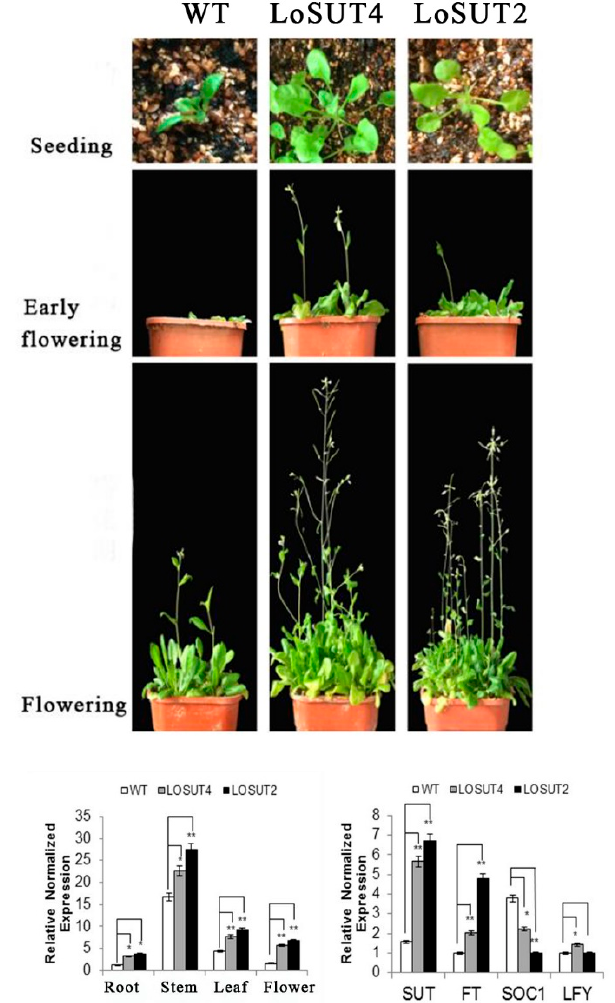
Figure 14. Overexpression of LoSUT2 and LoSUT4 in Arabidopsis and qPCR of wide type and transgenic Arabidopsis thaliana.